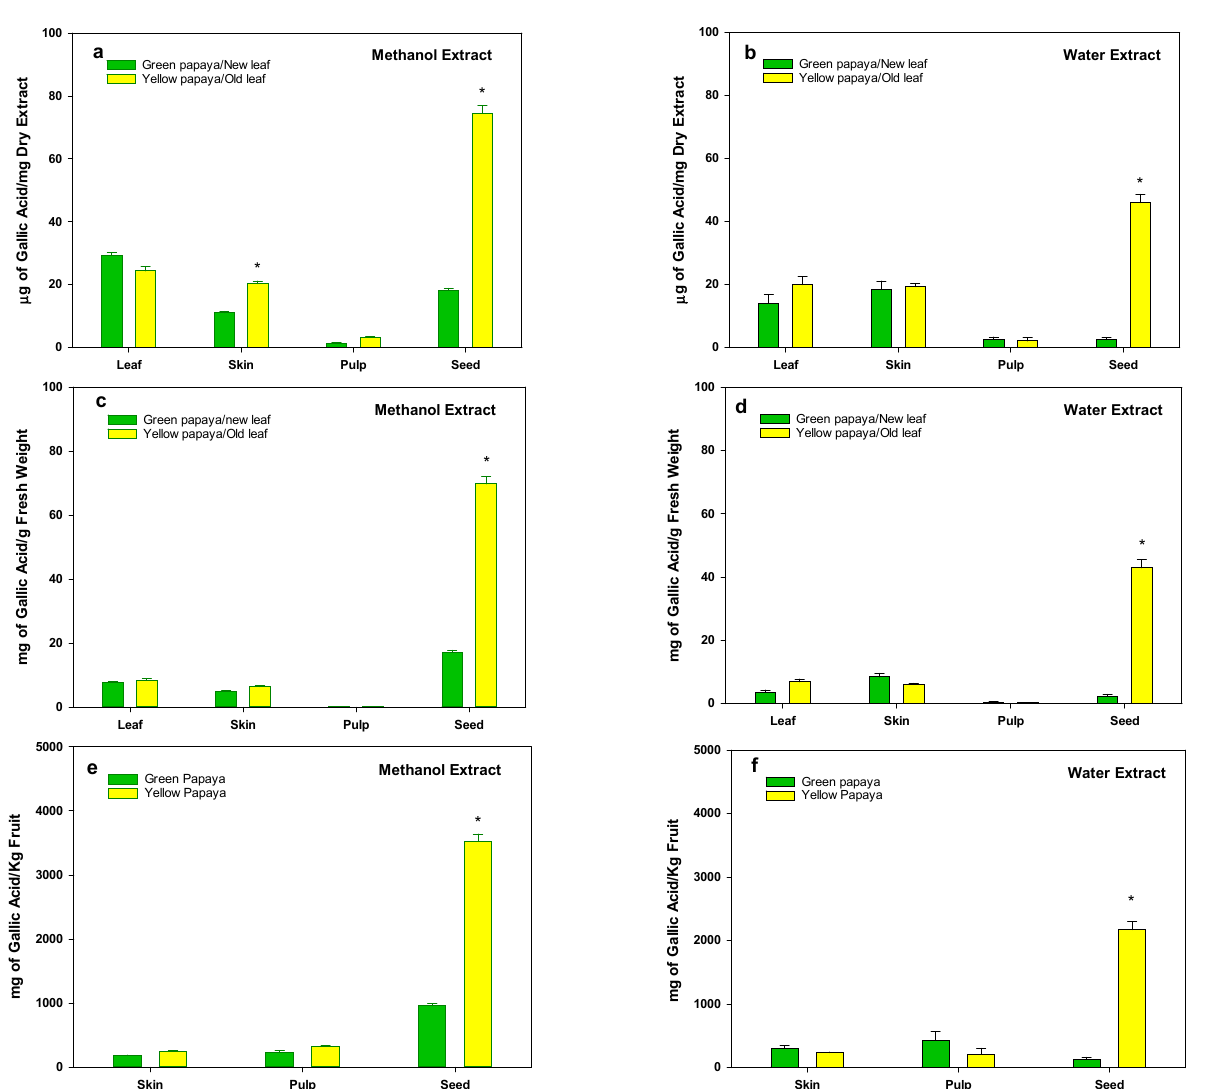
6 of 18 Table 1. Fraction of skin, pulp, and seeds in fresh papaya. Fresh Papaya Green papaya (g)